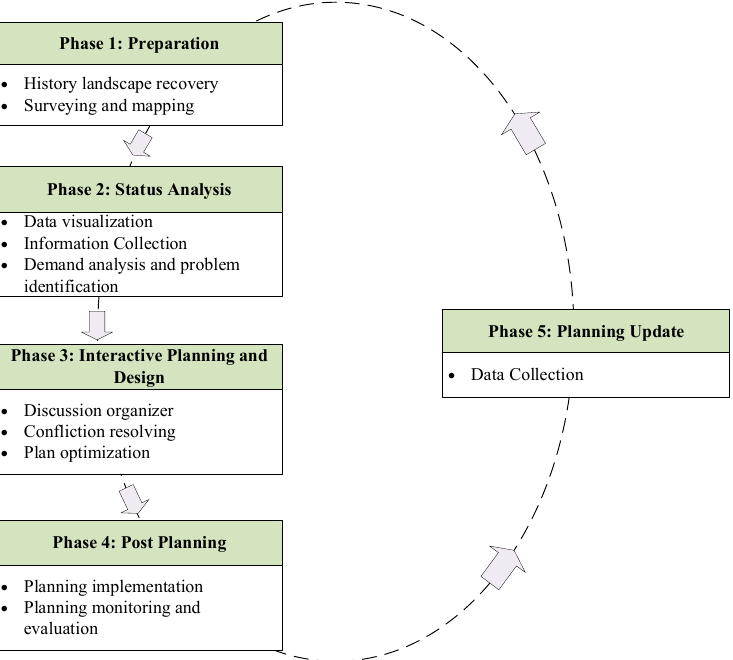
Figure 1. The workflow of 3D participatory geographic information system (PGIS)-based participatory spatial planning.